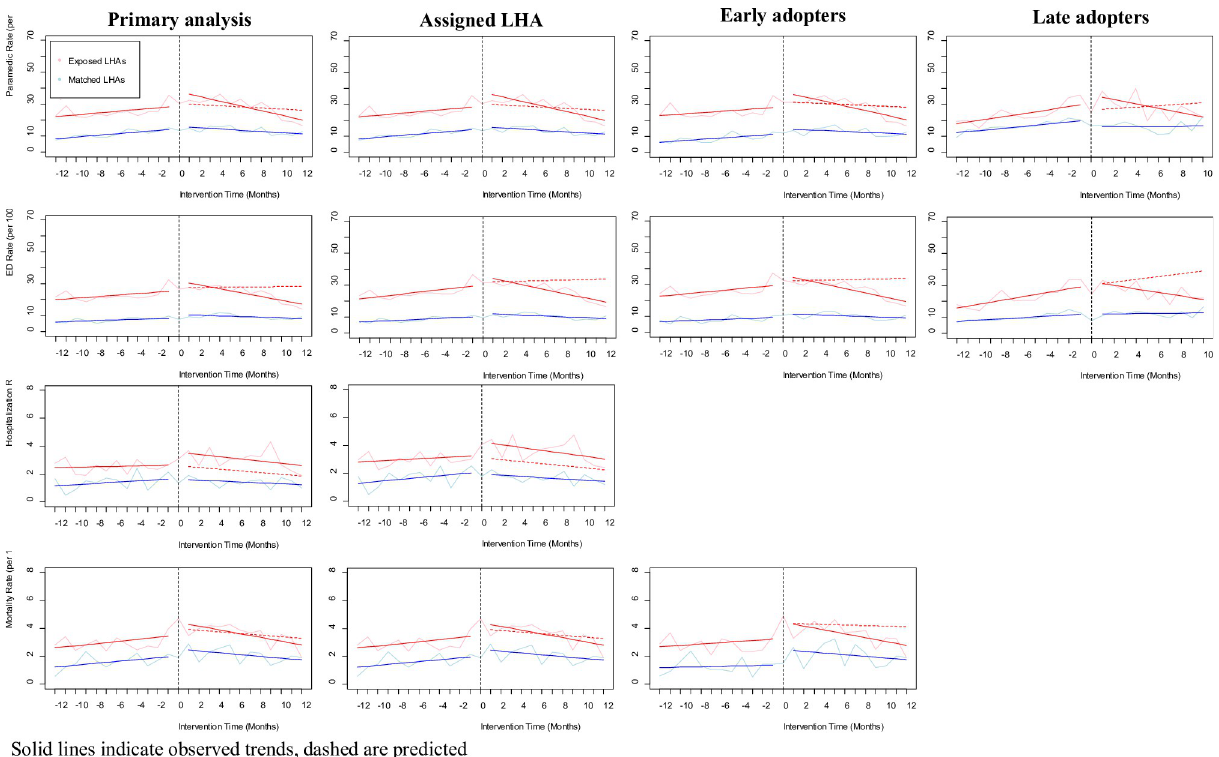
Fig 1. Panel of propensity score matched interrupted time series results, by analysis. Solid lines indicate observed trends, dashed are predicted.